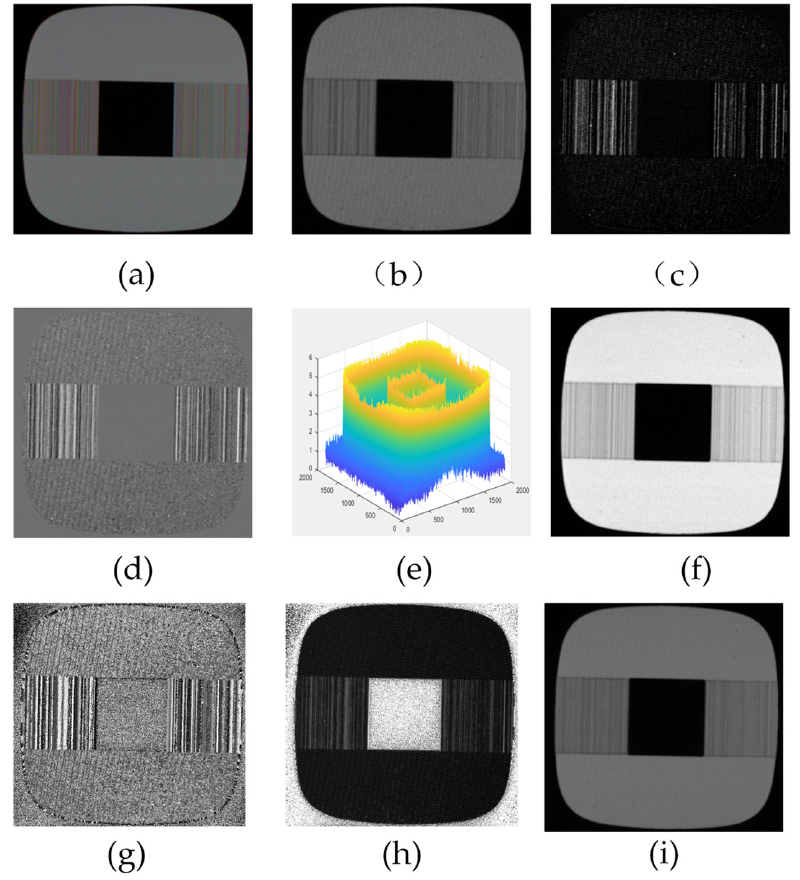
Figure 4. Decomposed feature map of various features of the original image. ( a ) Original image, ( b ) RGB space R channel, ( c ) RGBY space R channel, ( d ) Lab space a channel, ( e ) Two-dimensional information entropy H feature, ( f ) Average luminance feature I , ( g ) HSV spatial H channel, ( h ) HSV spatial S channel, ( i ) HSV space V channel.